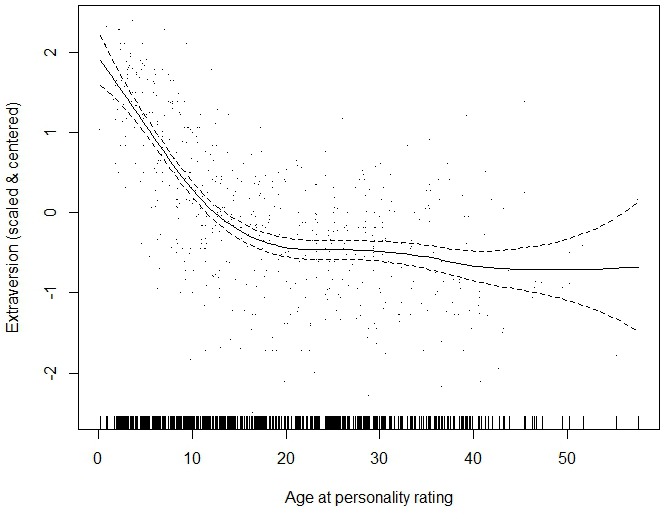
Generalized additive model of extraversion and age at personality rating.The carpet and scatter plot present the distribution of observations over which the best fit smoothed regression line is plotted with the 95% confidence region.